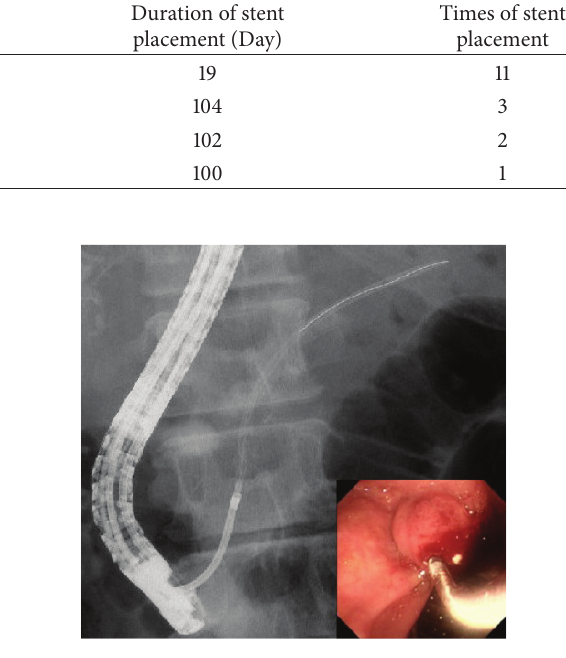
Figure 2: This retrieval technique is a method carried out by con- necting the distal end of the migrated stent to a stent retriever using a guide wire passed through the lumen of the migrated